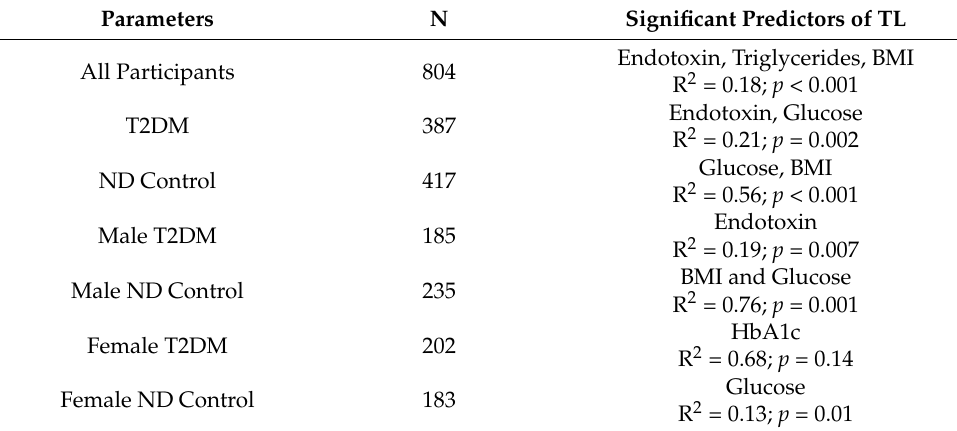
Table 5. Significant predictors of TL and